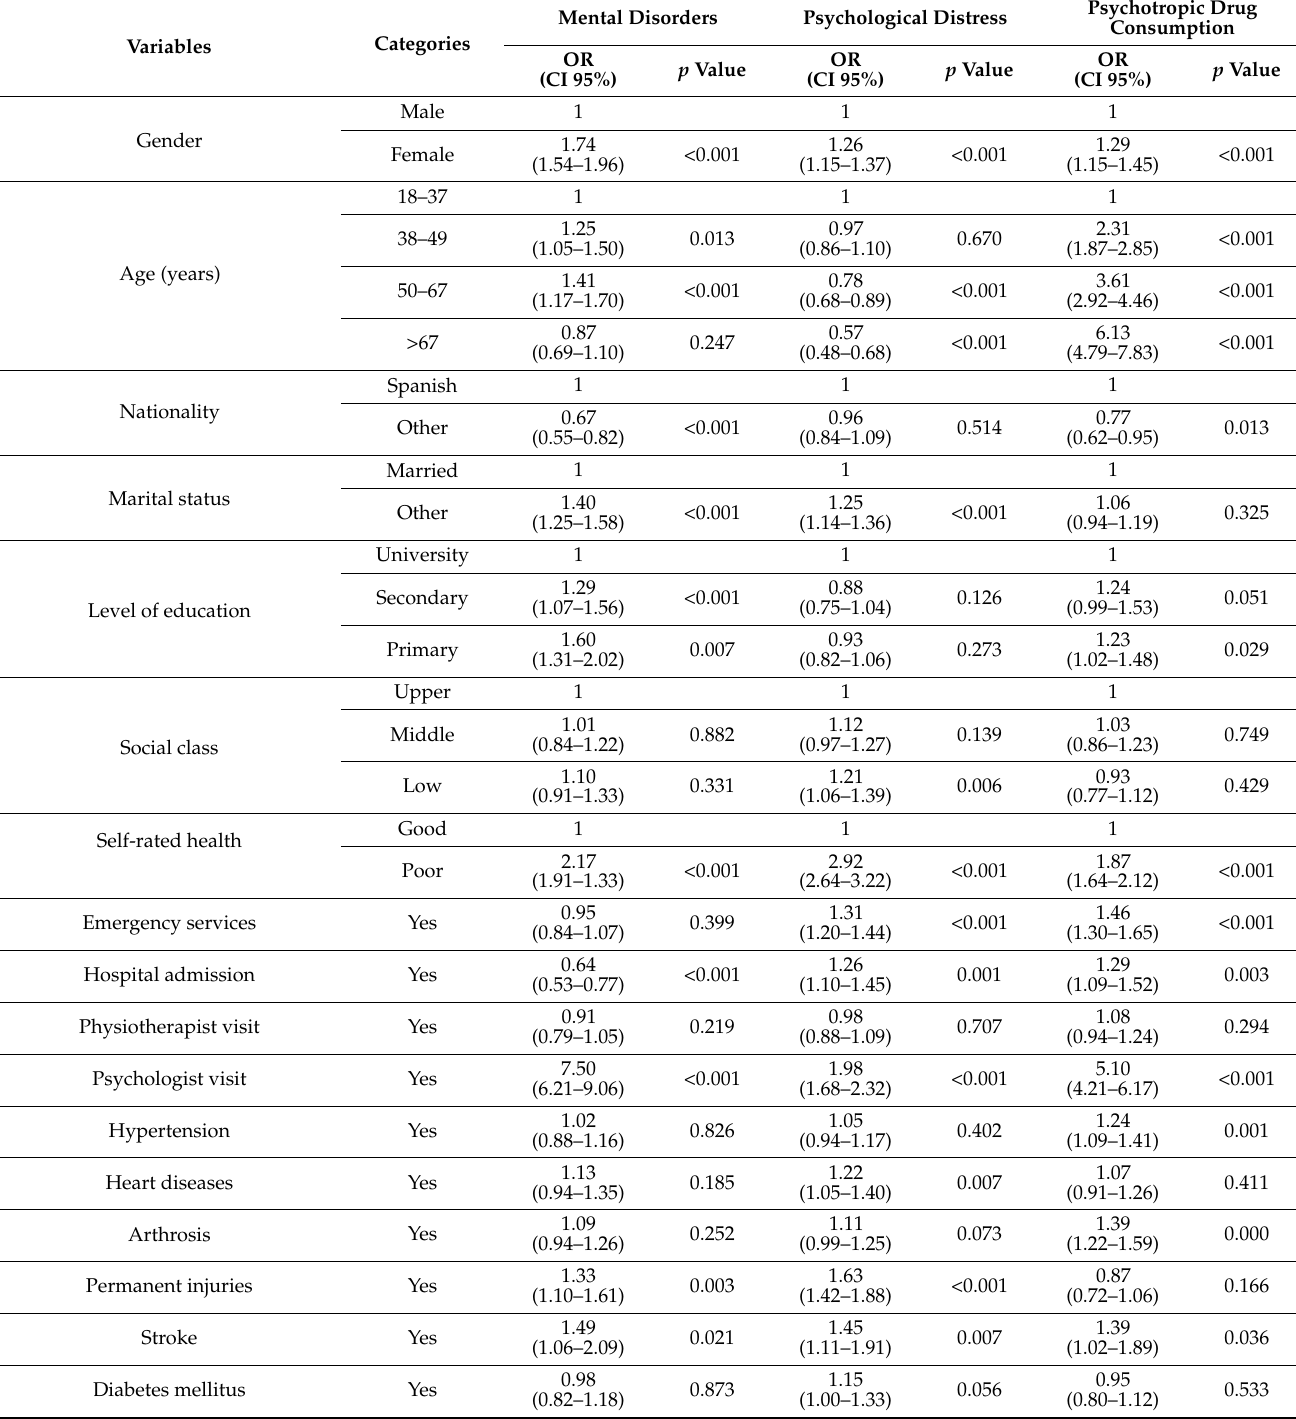
Table 4. Variables independently and significantly associated with mental disorders, psychologic distress and psychiatric drug consumption. Results from the Spanish National Health Interview Survey